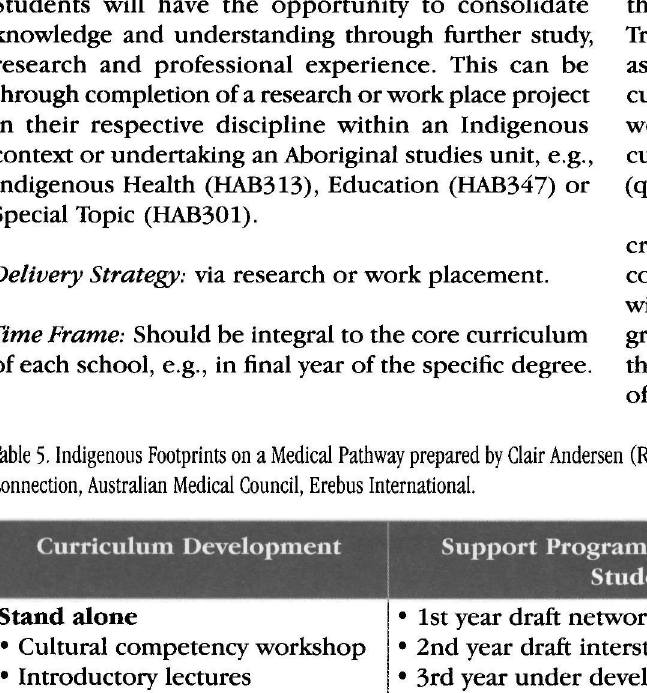
Table 5. Indigenous Footprints on a Medical Pathway prepared by Clair Andersen (Riawunna Centre) and Alison Miles (School of Medicine) for the LIME Connection, Australian Medical Council, Erebus